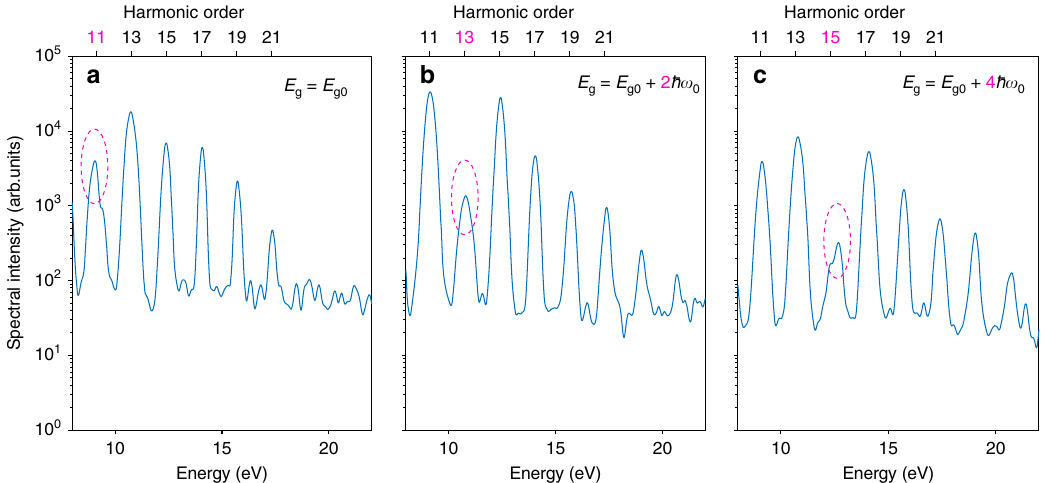
Fig. 7 Sensitivity of HHG spectra to the band gap. a – c , Spectra calculated from the numerical solution of the SBE, using the water electronic structure with the band gap changed from E g 0 = 6.2 eV to E g 0 + 2 ħ ω 0 and E g 0 + 4 ħ ω 0 . Destructive interference resulting in a local minimum at harmonic 11, 13, 15, can be clearly observed. For clarity of the demonstration, spatial integration was turned off in these calculations and a weaker electric fi eld strength of 0.7 V/Å has been